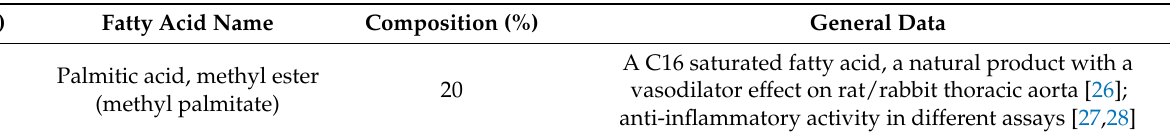
Table 5. Chemical composition of F1, according to GC–MS